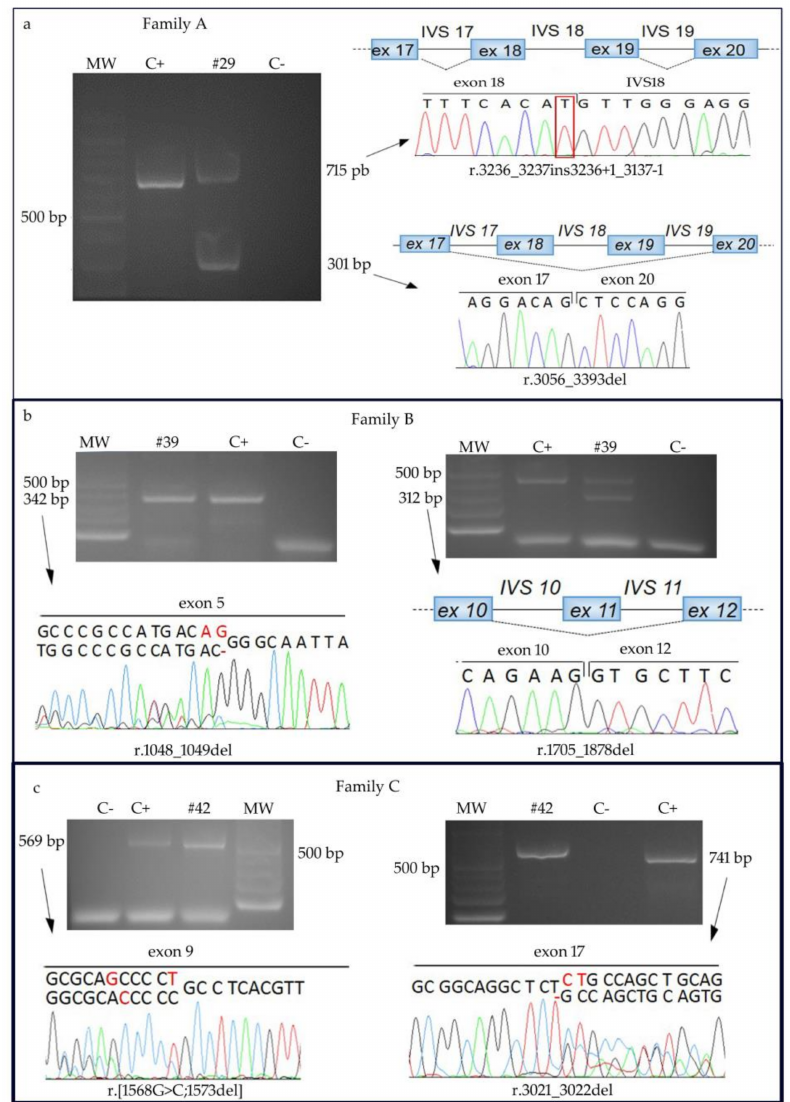
Figure 2. RECQL4 transcript analyses in RTS families A, B, C. ( a ) Agarose gel showing two aberrant RT-PCR products in patient #29 homozygous for c.3236G>T alteration: sequencing of the slower migrating band shows intron 18 retention (76 nucleotides) while electropherogram obtained from the faster migrating band reveals skipping of exons 18 (181 nt) and 19 (157 nt). ( b ) Left panel: electopherogram of the RT-PCR product (exons 5–7) including the heterozygous c.1048_1049del of patient #39 highlights the lack of two nucleotides (in red). The wild-type sequence refers to the other allele of the patient carrying a downstream deletion. Right panel: agarose gel of the RT-PCR product of exons 9–13 amplicon and electropherogram of the faster migrating band showing a mis-spliced transcript lacking exon 11 (174 nt) due to the IVS11 c.1878+32_1878+55del deletion. The wild-type amplicon refers to the other patient allele carrying an upstream deletion. ( c ) Left panel: electropherogram of the RT-PCR product (exons 7–12) including the heterozygous c.[1568G>C;1573delT] of patient #42 highlights the out-of-frame change (in red) transversion and the in cis close deletion. The wild-type sequence refers to the other allele of the patient carrying the downstream exon 17 deletion. Right panel: electropherogram of the RT-PCR product (exons 15–20) including the heterozygous c.3021_3022del of the patient. The wild-type sequence refers to the other patient allele with the upstream exon 9 transversion/deletion. MW: molecular weight markers; C+: positive control (cDNA of a healthy individual); C-: negative control (no template